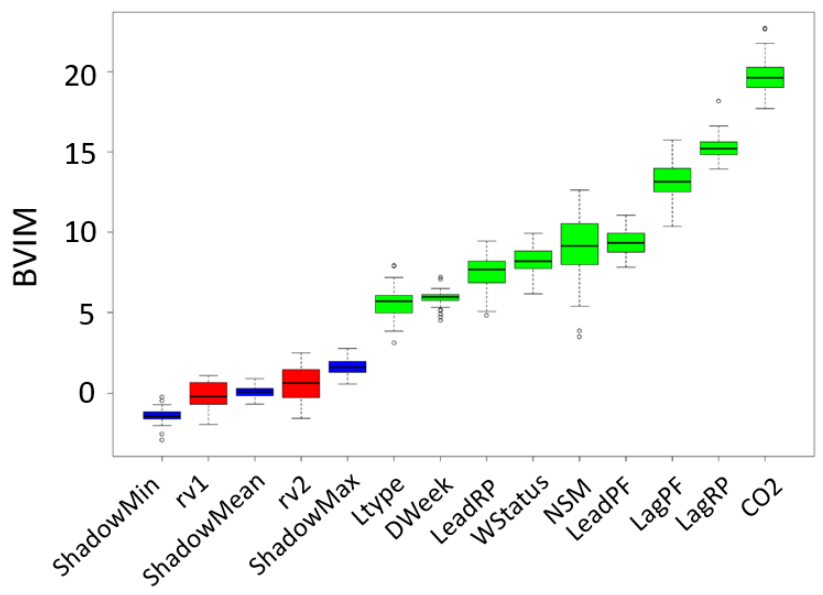
Figure 6. Boruta analysis of the importance of predictors of energy use in a steel plant (Sathishiku- Figure 6. mar et al. [24]).